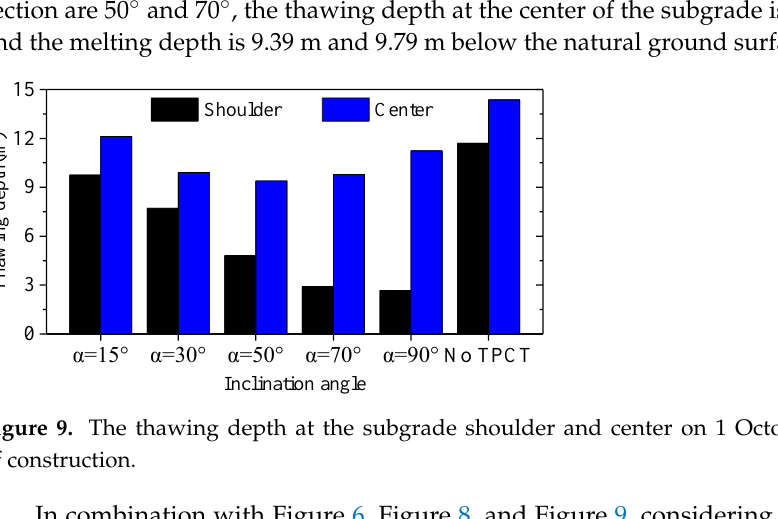
Figure 8. Geotemperature distributions of subgrades with L- shaped TPCTs under different α values on 1 October of the fifth year after their construction (unit: °C ): ( a ) α = 15°; ( b ) α = 30°; ( c ) α = 50°; ( d ) α = 70°; € α = 90°.